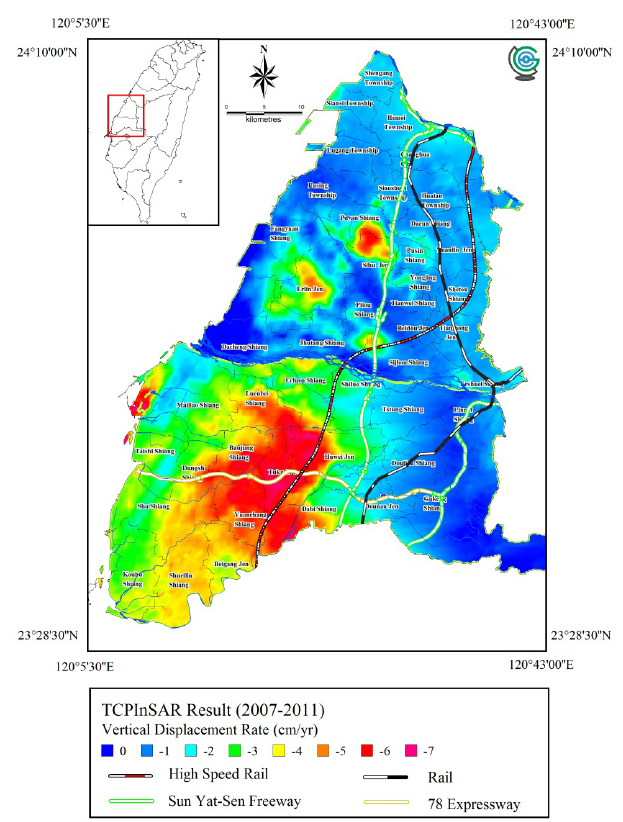
Figure 9. Vertical displacement rate from TCPINSAR over 2007–